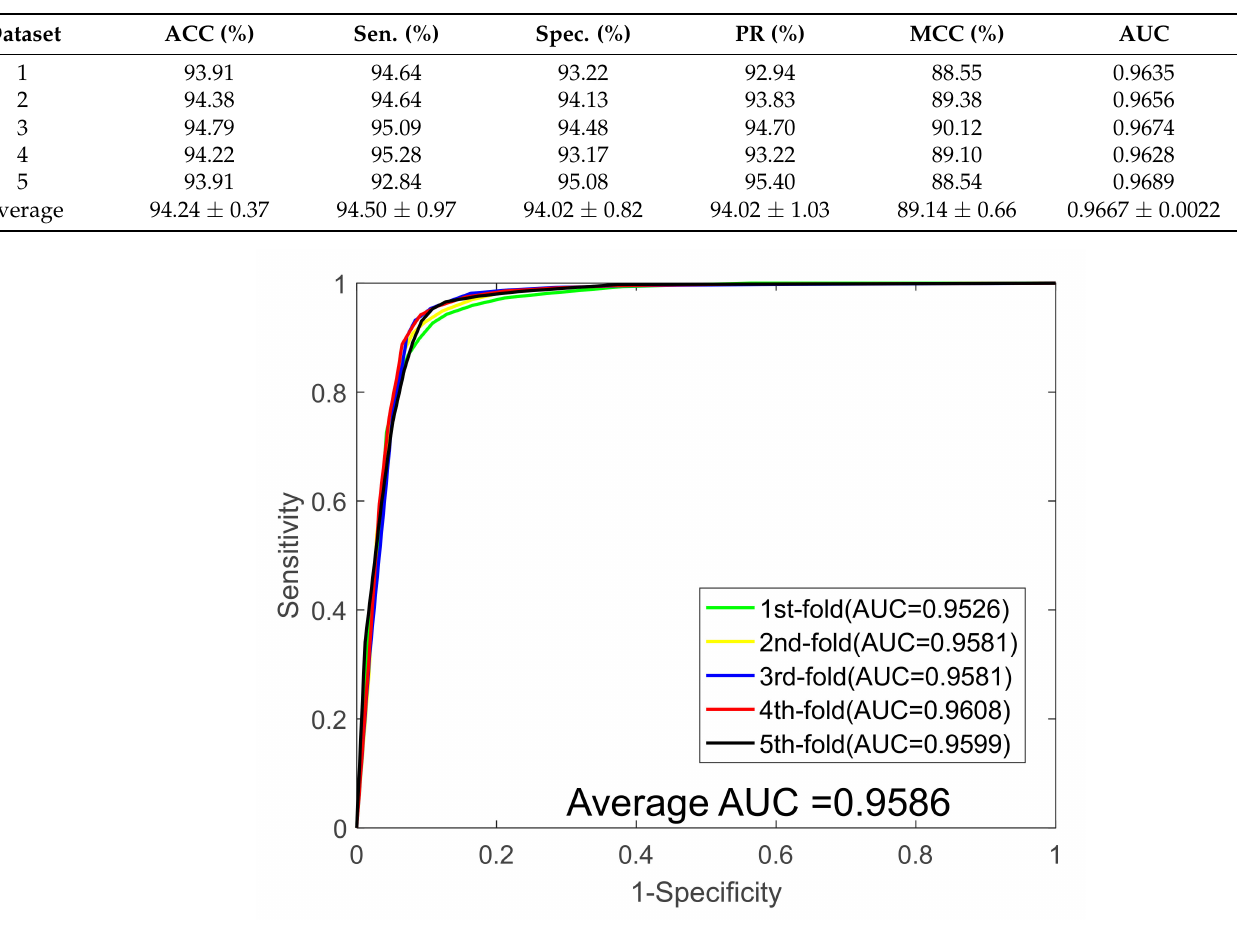
Table 3. Five-fold CV results performed by the proposed model on the Oryza sativa PPIs dataset.